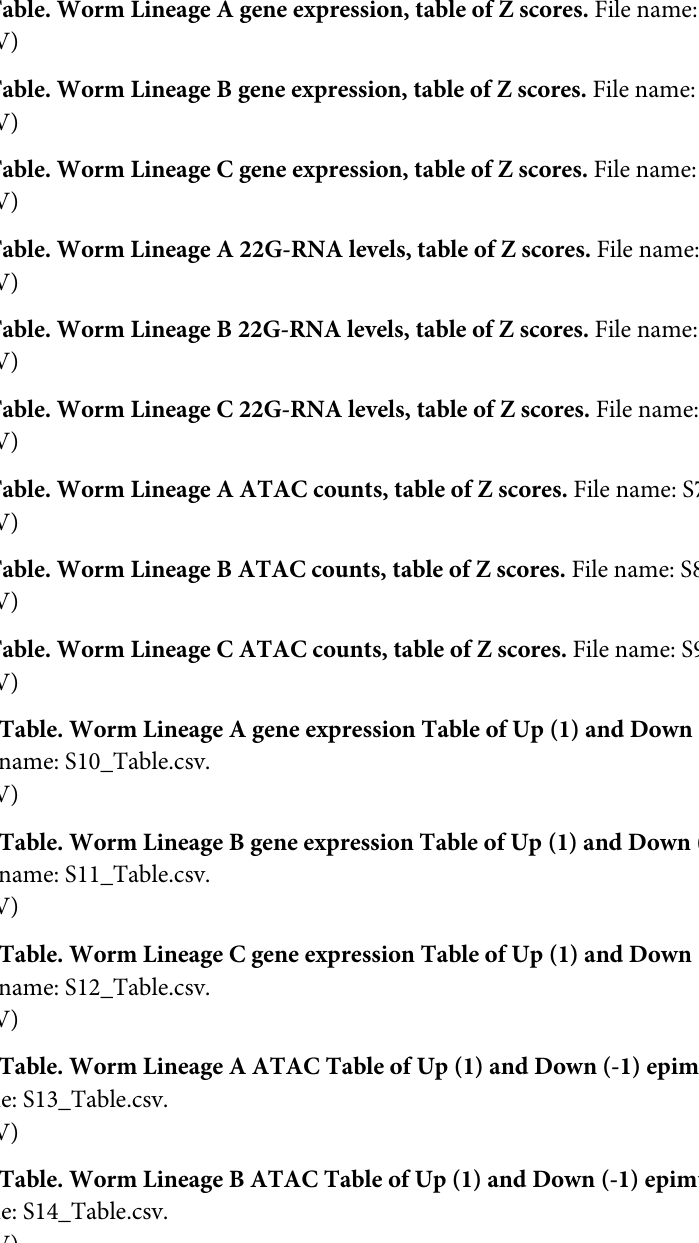
S1 Table. Worm Lineage A gene expression, table of Z scores. File name: